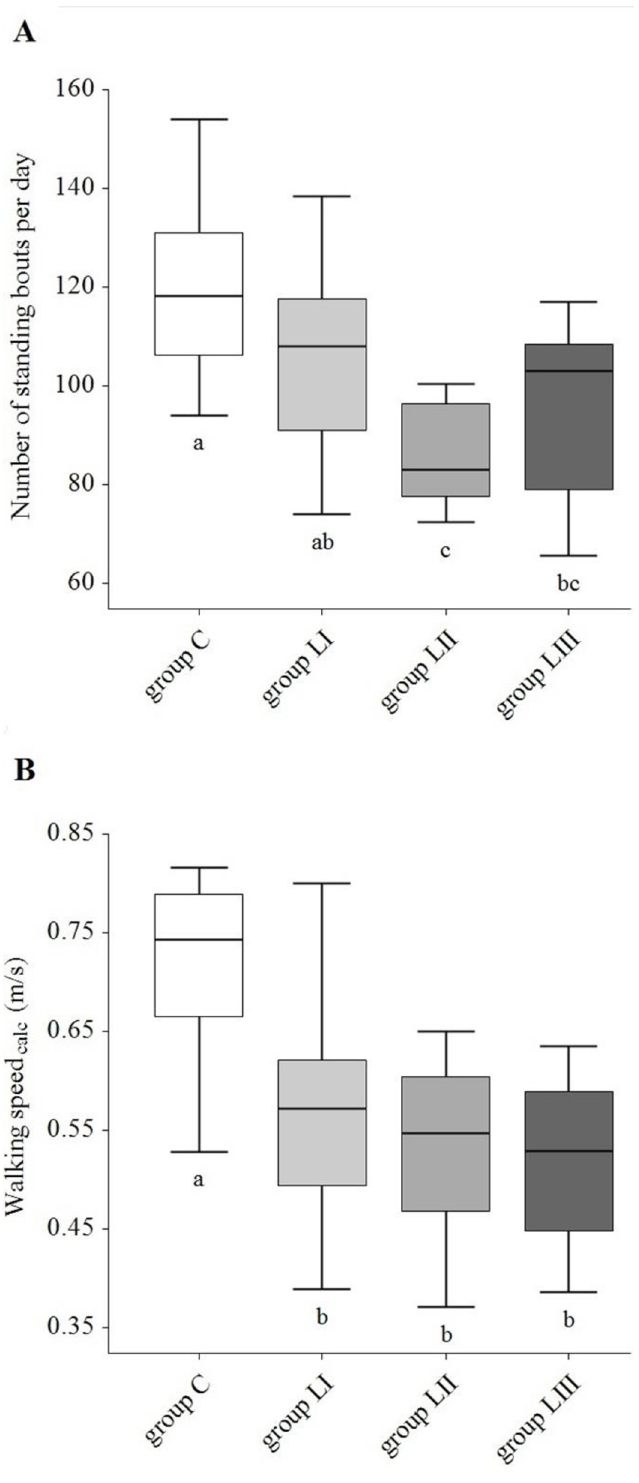
Fig 2. Box Plot representations of number of standing bouts (A) and walking speed calc (B) of group C (NRS (cid:3) 2), group LI (NRS = 2.5 – 3), group LII (NRS = 3.5) and group LIII (NRS (cid:1) 4). Different characters (a, b, c) indicate a significant difference ( P < 0.05). Numerical rating system (NRS) is according to Flower and Weary [38].